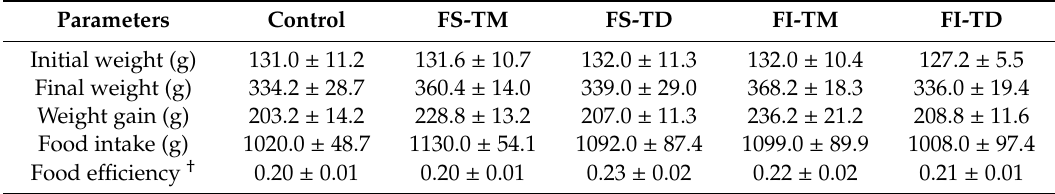
Table 3. Weight gain, food intake, and dietary e ffi ciency in rats fed with the experimental diets. Parameters